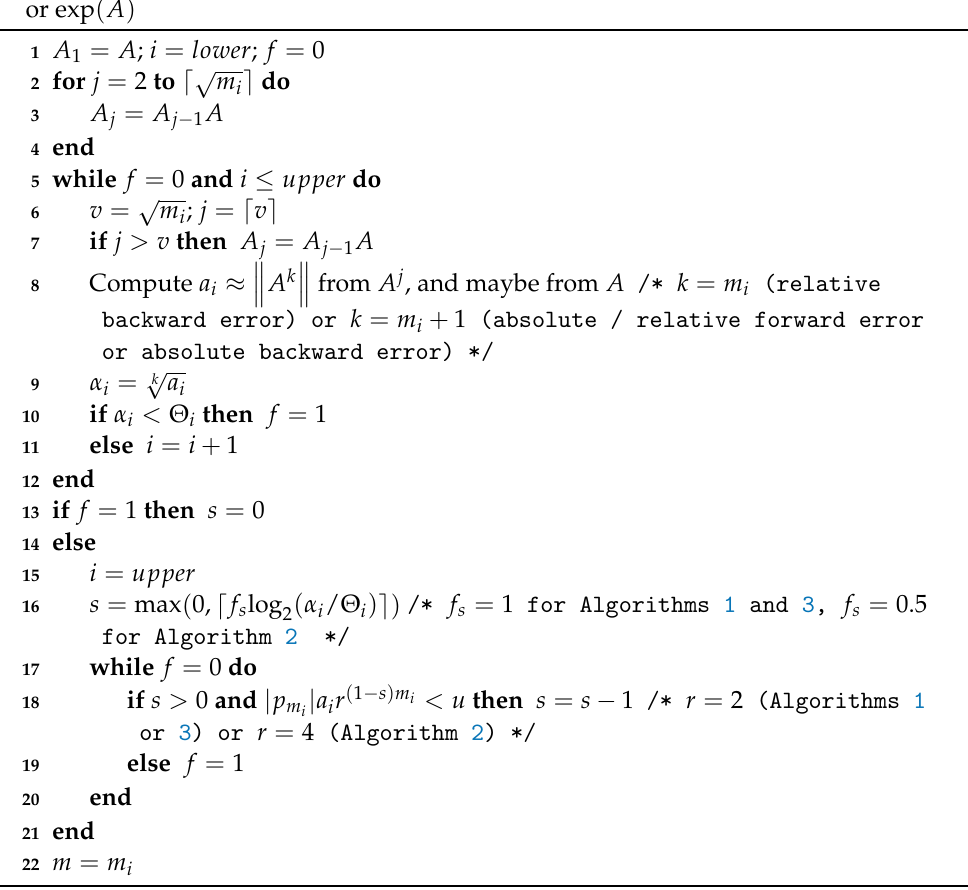
Algorithm 4: Given a matrix A ∈ C r × r , a minimum order m lower ∈ M and